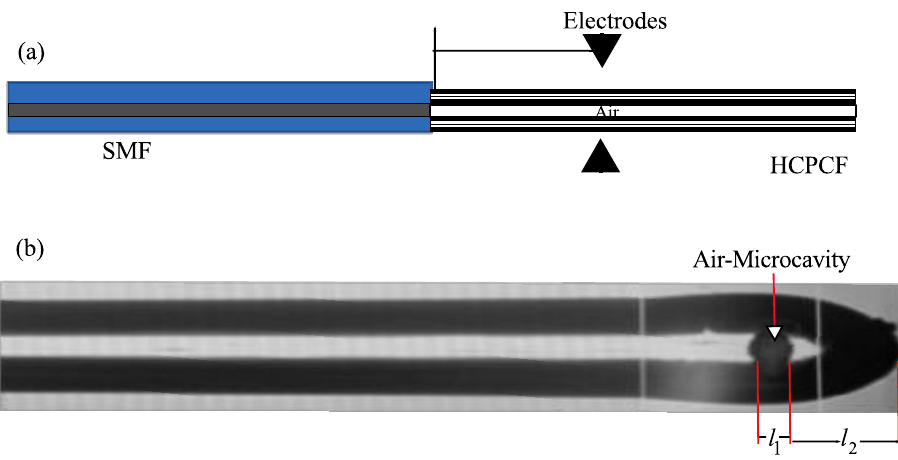
Figure 2. Air-Microcavity fabrication procedure: ( a ) Offset cut distance; ( b ) Example an IFPI fabricated using m and seven arc